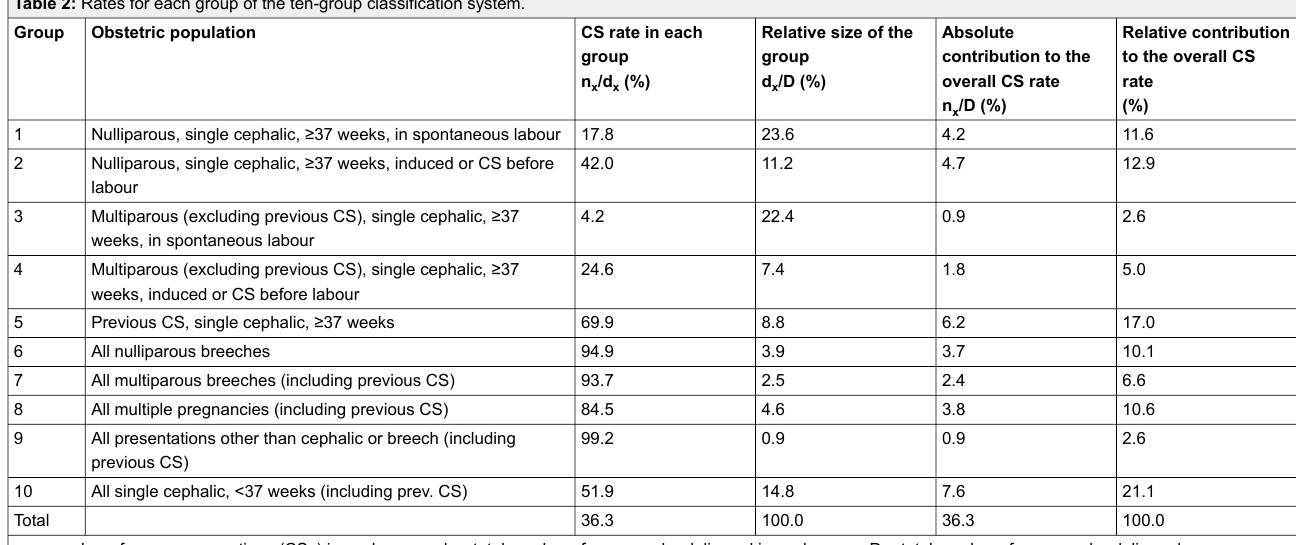
Table 2: Rates for each group of the ten-group classification system. Group Obstetric